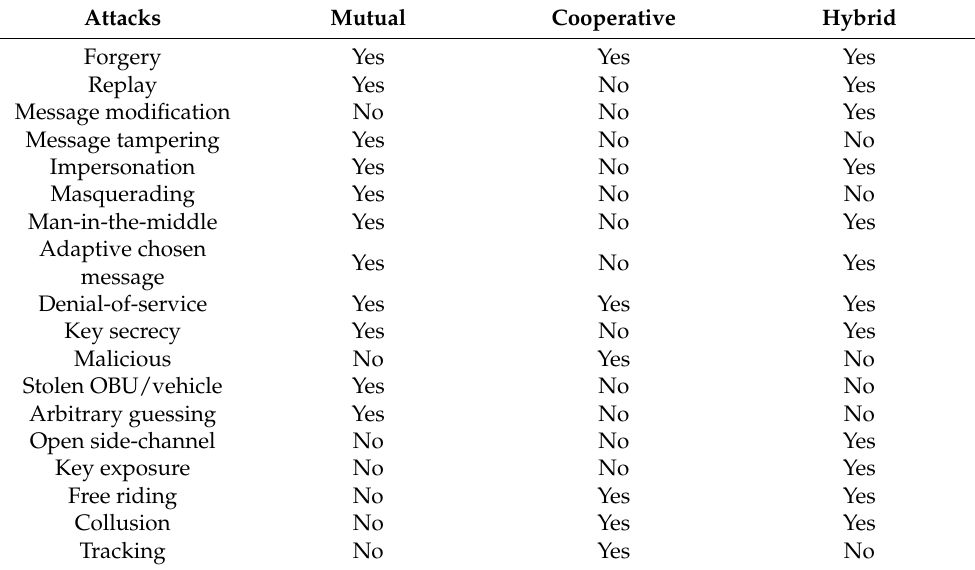
Table 16. Comparison based on attacks mitigated by mutual, cooperative, and hybrid authentication